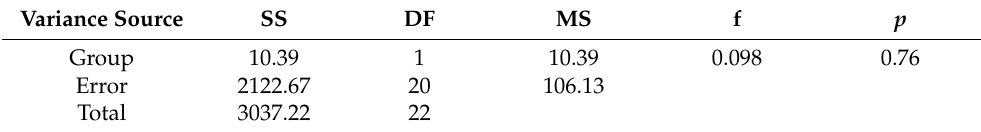
Table 6. ANCOVA results of the high-achievement students between the two groups. Variance Source